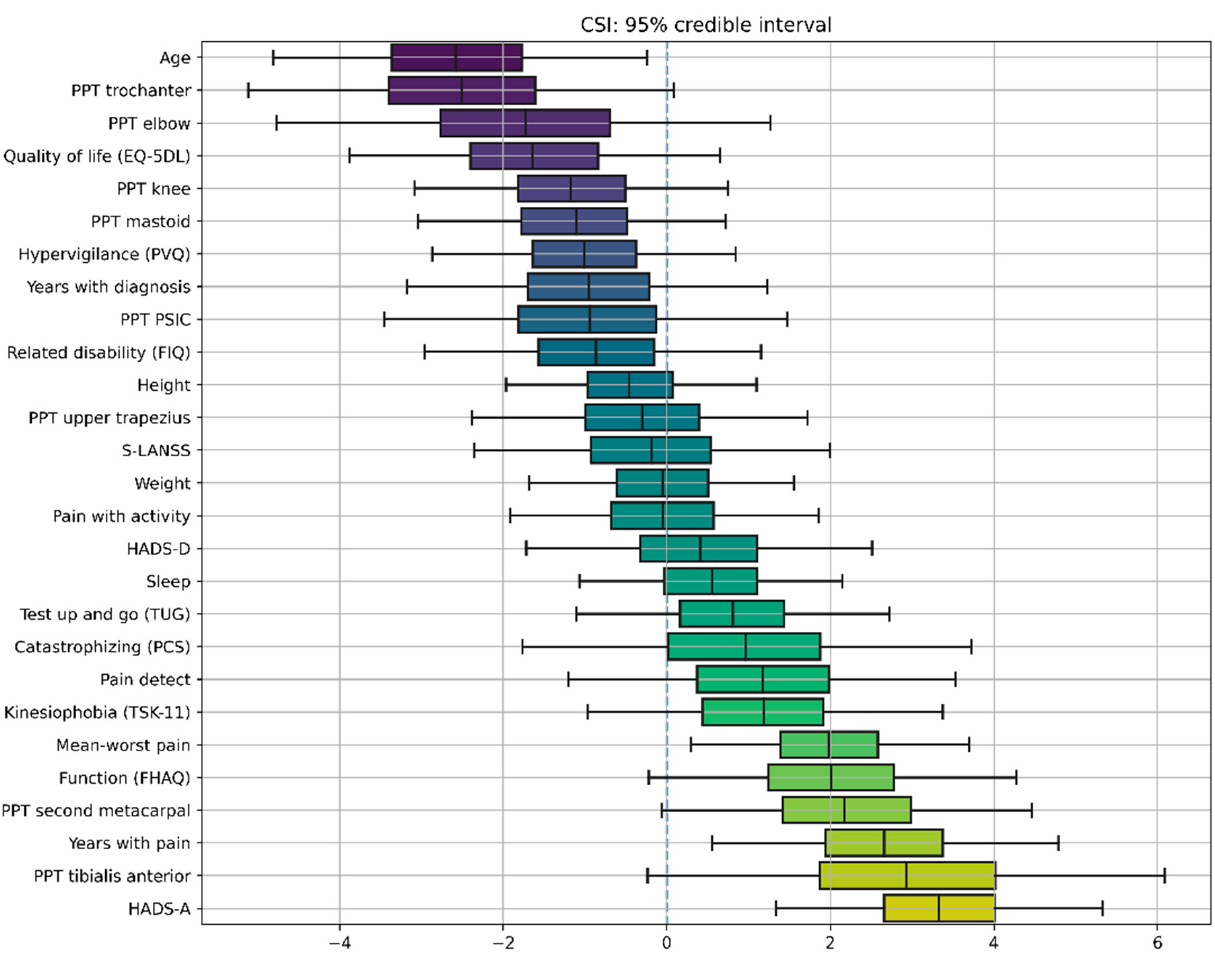
Figure 2. Credible intervals for all the parameters in the Bayesian Linear Regression (BLR) model for Central Sensitization Inventory (CSI). The X axis represents the values of the coefficients of the model, which are random variables, meaning that they do not have a specific value, but rather a “probabilistic value”, with some values being more probable than others. The negative sign (left side of the figure) means that the correlation with the CSI score is negative. The positive sign (right side of the figure) means that the correlation with the CSI score is positive. The magnitude, e.g., 3.5, indicates the relative strength of that correlation; it is relative in the sense that you can directly compare different coefficients because variables have been standardized. Accordingly, boxplots represent the distribution of a model coefficient, with whiskers enclosing its 95% credible interval. The 95% credible interval of a model coefficient is the range of values within which 95% of its probability falls.